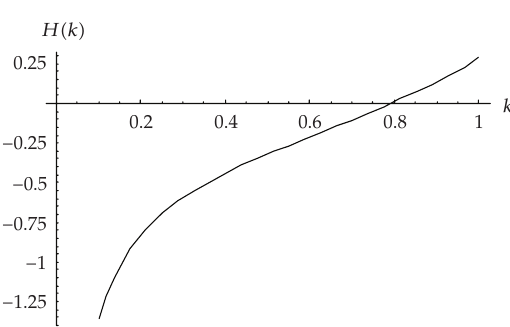
Figure 1: The existence of a unique equilibrium point.